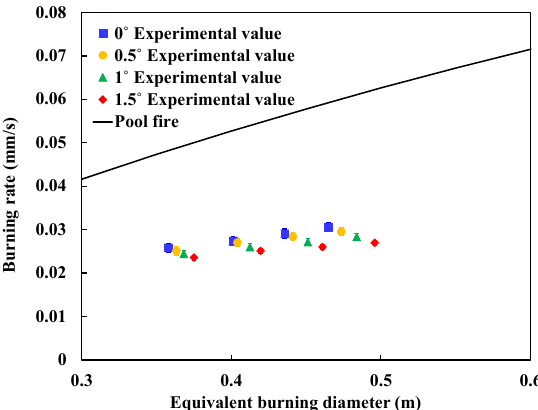
Figure 10. Comparison of burning rate between spill fire and pool fire.